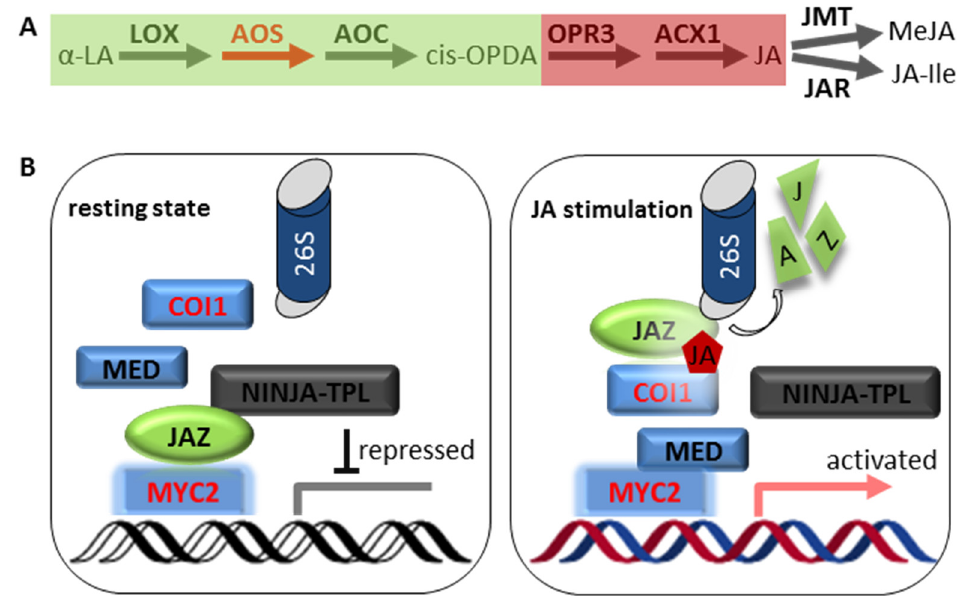
Figure 3. Jasmonate (JA) biosynthesis and signaling transduction pathway. ( A ) Model for the JA biosynthesis pathway. The intermediate OPDA is synthesized in the chloroplasts. JA is synthesized in the peroxisomes and exported to the cytosol, where it is converted to other bioactive derivates (i.e., JA-Ile). The key enzyme AOS is highlighted in red. ( B ) Model for the JA signaling transduction pathway of the MYC-branch in Arabidopsis. In the non-induced cells (left, low JA level), MYC2 activity is repressed by JAZ proteins that interact with NINJA to recruit transcriptional repressor TPL. In the JA-stimulated cell (right, high JA level), JAZ proteins are degraded by the SCF COI1 -mediated 26S-proteosome. MYC2 is released to interact with the transcriptional mediator to activate JA- responsive gene expression. Abbreviations: α-LA, α-linolenic acid; ACX1, acyl-CoA-oxidase 1; AOC, allene oxide cyclase; AOS, allene oxide synthase; COI1, coronatine insensitive 1; JA, jasmonic acid;